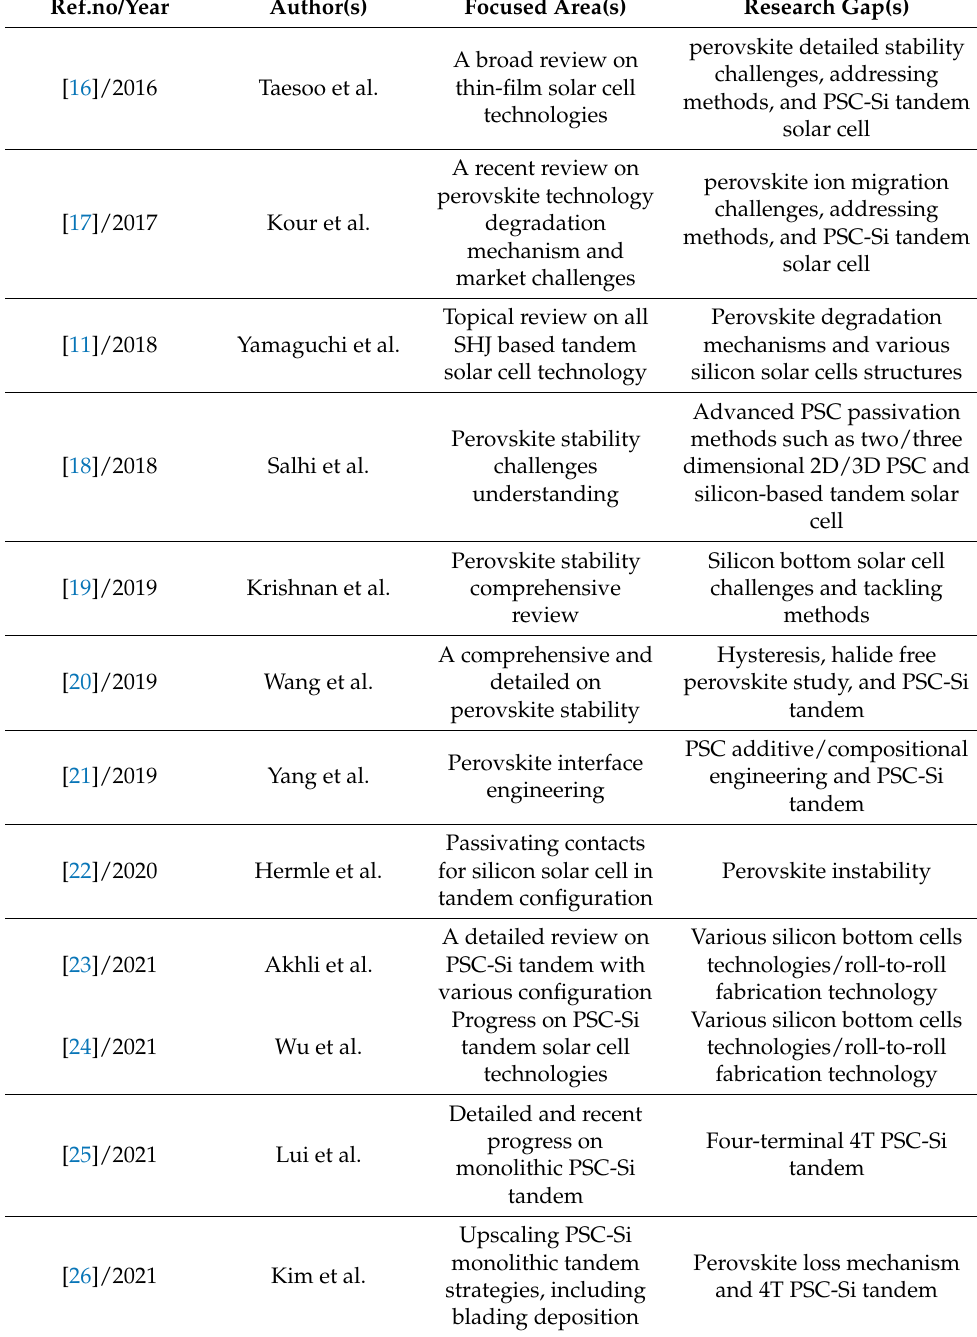
Table 1. Recent research gap studies on perovskite, silicon, and PSC-Si tandem solar